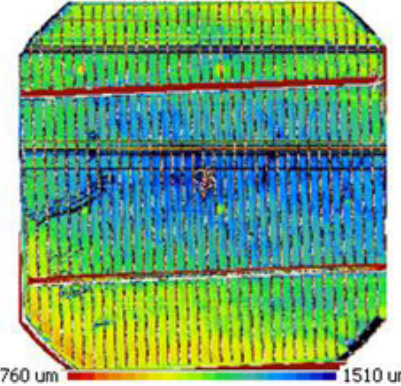
Figure 6. Two-dimensional distribution of the minority carrier diffusion length of the thin n + np + solar cell (L Phosphorus diffusion was performed at 855 °C; T